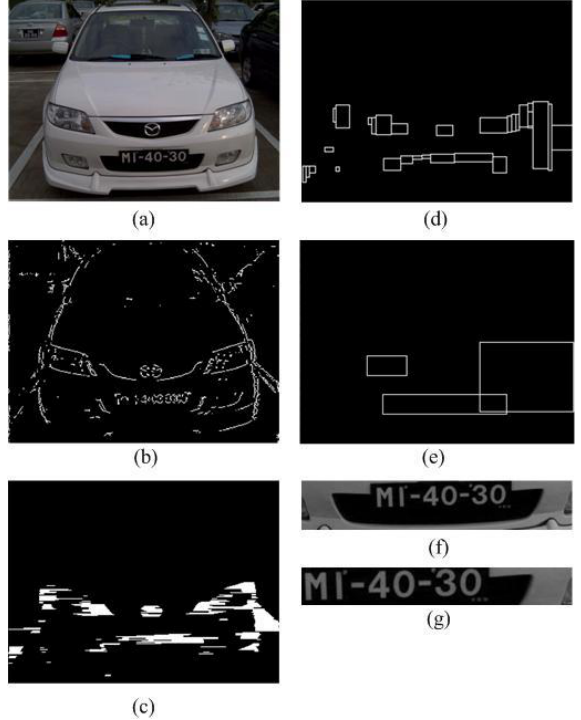
Figure 8 : Extraction result. (a) Original image. (b) Vertical edge map. (c) Edge lines. (d) Line-combined rectangle. (e) Merged rectangle. (f) Identified plate region. (g) Optimized plate